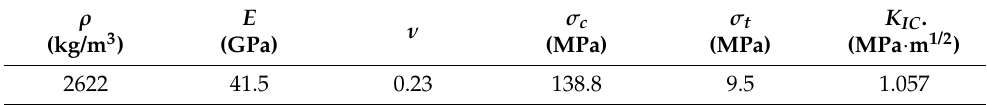
Figure 7. Force–displacement curves measured from three-point bending tests. Table 1. The basic mechanical properties of